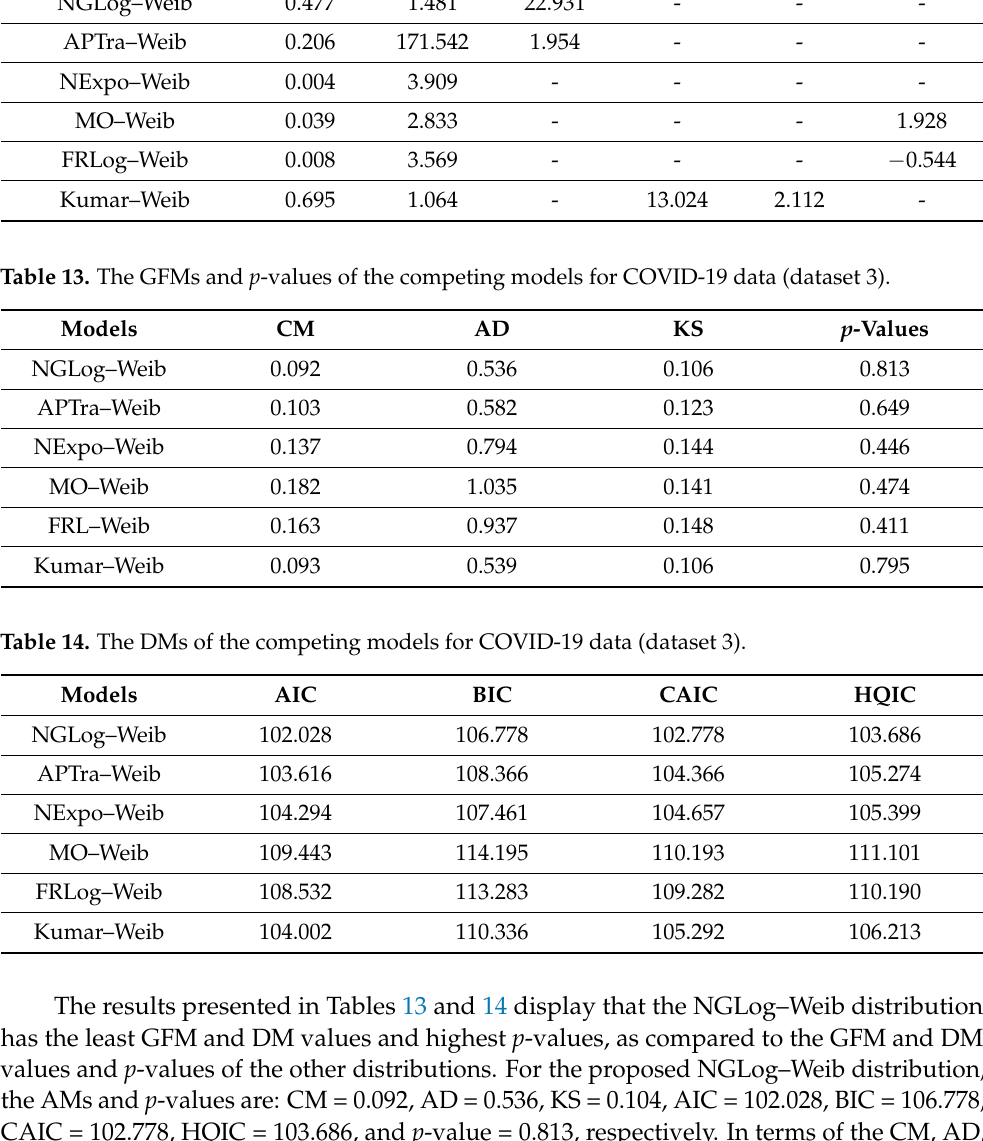
Table 12. The ˆ β MLE , ˆ α MLE , ˆ δ MLE , ˆ a MLE , ˆ b MLE and ˆ θ MLE values for COVID-19 data (dataset 3). Models